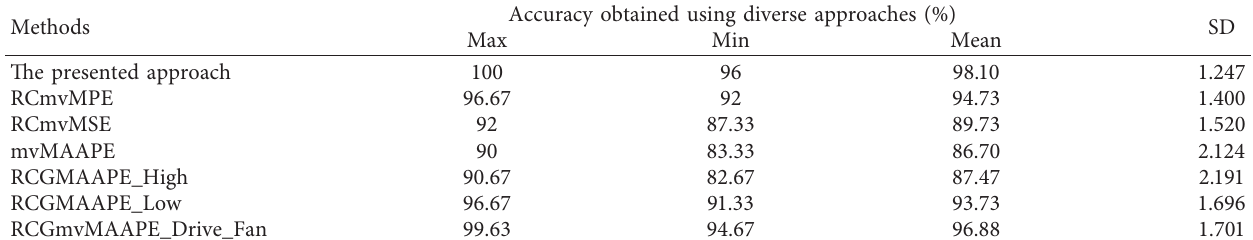
Figure 23: The diagnostic result of the seven feature extraction models in 20 trials. Table 5: Recognition result of seven methods in 20 trials.